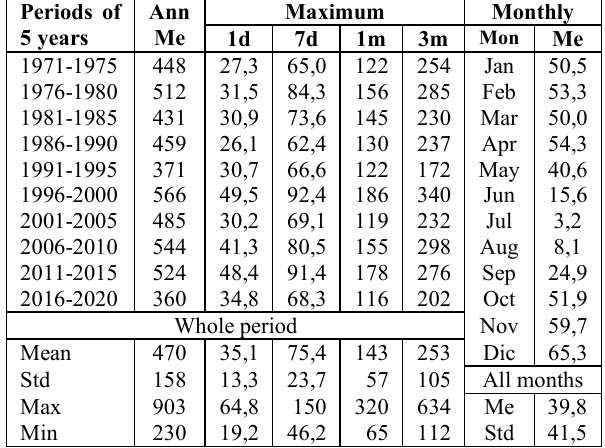
Table 6. Rainfall data (mm). AnnMe (annual means), maximum in 1 day, 7 days, 1 month and 3 months